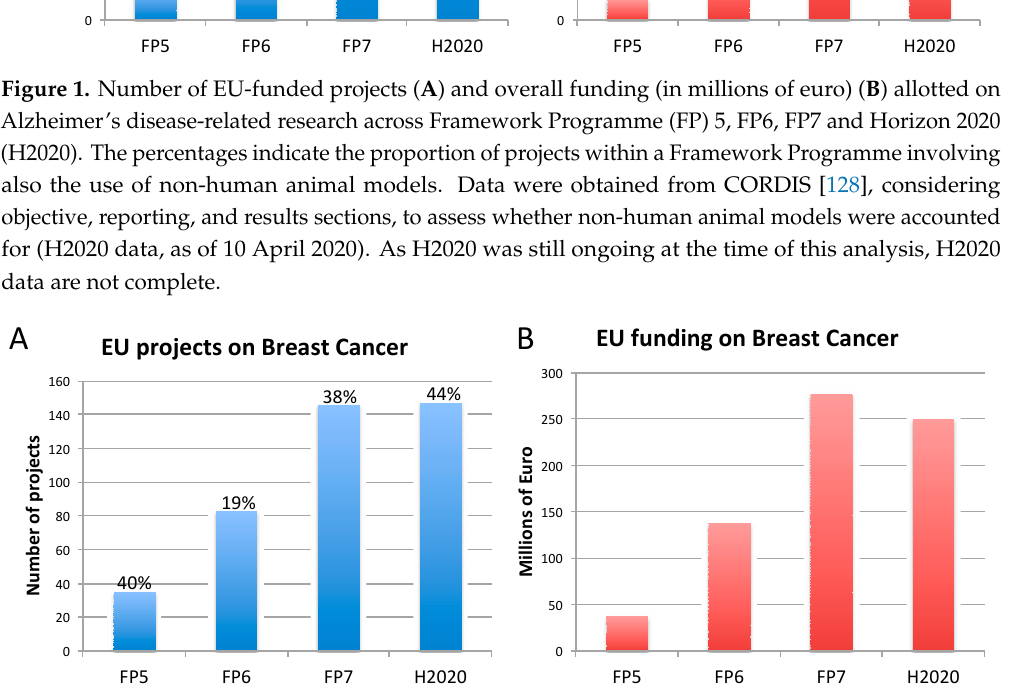
Figure 2. Number of EU-funded projects ( A ) and overall funding (in millions of euro) ( B ) allotted on breast cancer-related research across Framework Programme (FP) 5, FP6, FP7 and Horizon 2020 (H2020). The percentages indicate the proportion of projects within a Framework Programme involving also the use of non-human animal models. Data were obtained from CORDIS [128] , considering objective, reporting, and results sections, to assess whether non-human animal models were accounted for. FP7 and H2020 data were obtained using the EC CORDA database (H2020 data, as of May 15, 2019). As H2020 was still ongoing at the time of this analysis, H2020 data are not complete.